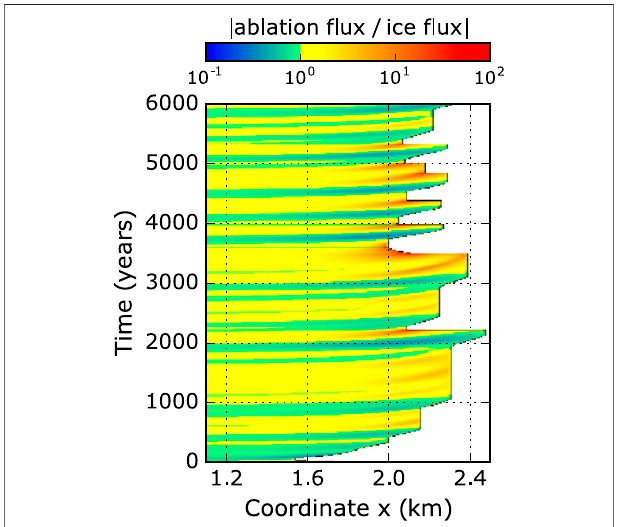
FIGURE6| Evolutionoftheratiobetweenablation fl uxandice fl uxforthe oscillatingexperiment(magentacurvein Figure5 )with ζ (cid:1) 0.5 % and β 2 (cid:1) 0.01, calculated at each node. The ablation fl ux results from integrating from the current node to the downstream end of the glacier. The ice fl ux is calculatedbyintegratingtheice fl owthroughaverticallineatthecurrentnode. The ratio increases when the glacier advances, due to an increase of the ablation area. A clear divergence is evident at locations where the glacier collapses. The collapse reduces the length of the ablation area, which results in values of the fl ux ratio below one (green to blue), which initiates a new advance phase.